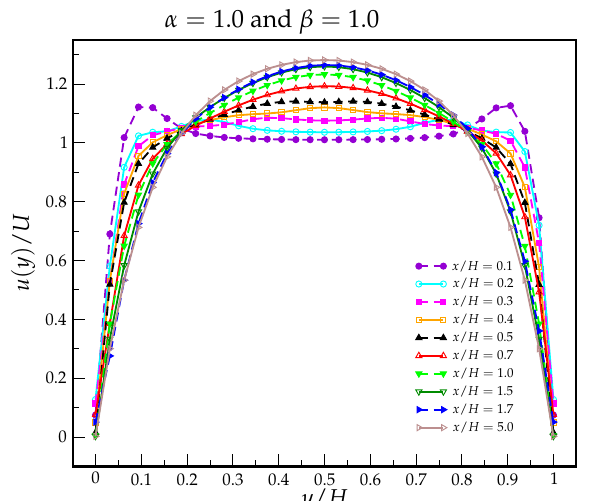
Figure 10. Velocity profiles obtained at 10 different sections of the channel for Wi = 1.0, α = 1, β = 1. (a) α = 0.5 and β = 0.5 (b) α = 0.5 and β = 1.5